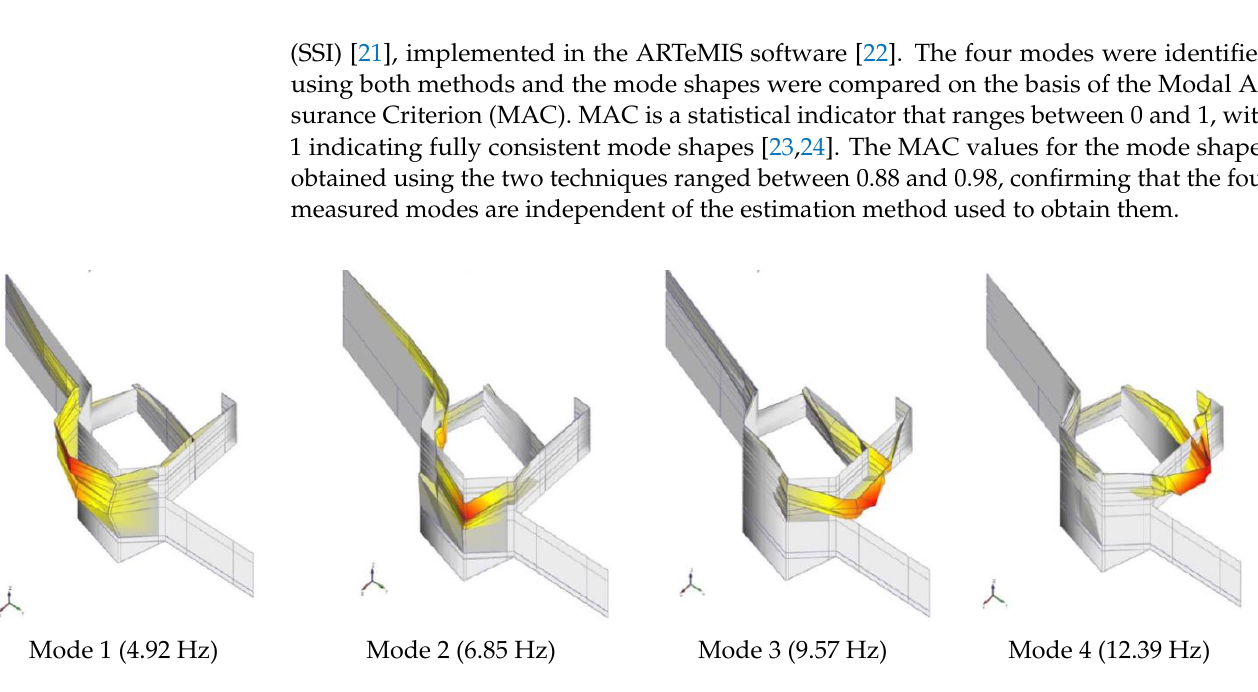
Figure 15. Mode shapes and natural frequencies of the first four modes identified in the tower. The first mode corresponds to the out-of-plane movement of the eastern wall EW3.